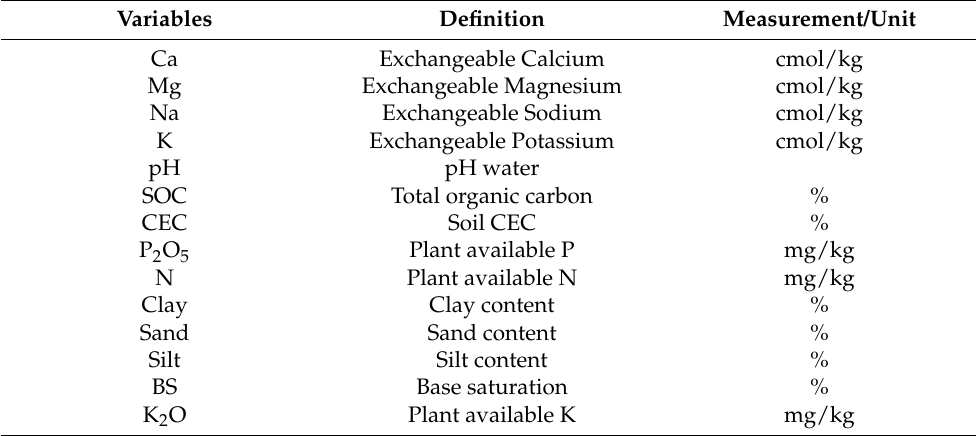
Table 1. The selected soil properties variables for Factor analysis and clustering.